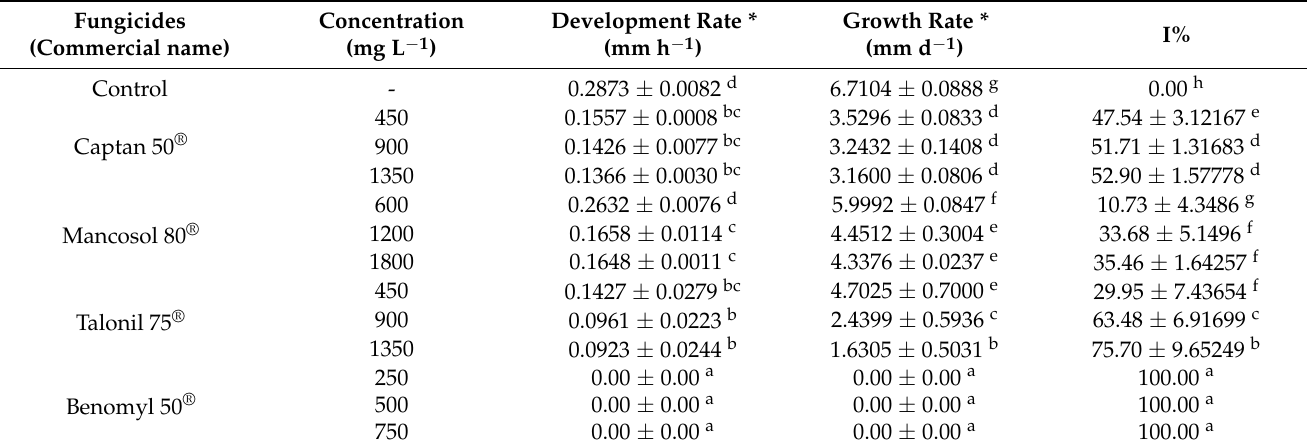
Table 4. In vitro efficacy of four fungicides on the rate of development, speed of growth, and percentage of inhibition of mycelial growth of the MA-FC120 strain.